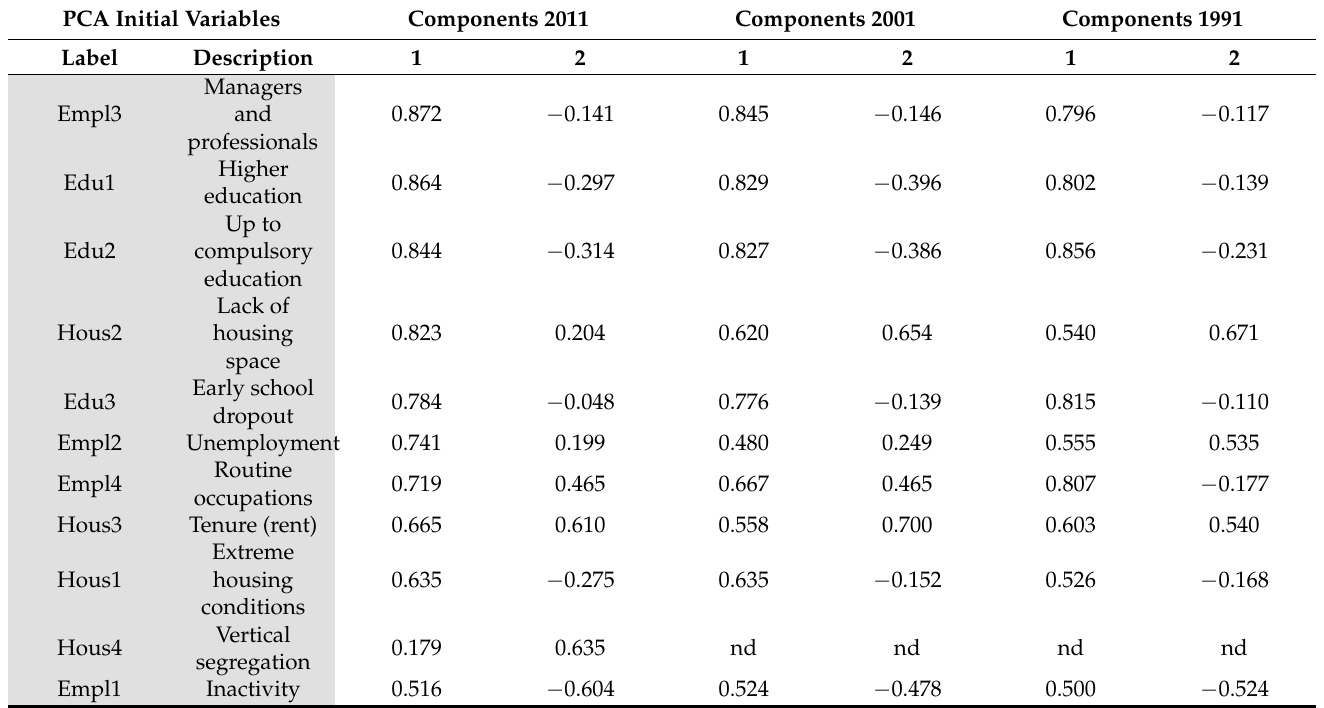
Table 3. Correlation between initial variables and PCA